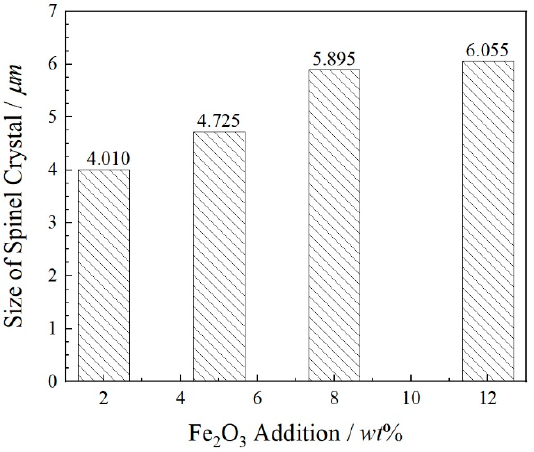
Figure 7. Variation behavior of spinel crystal size in samples.